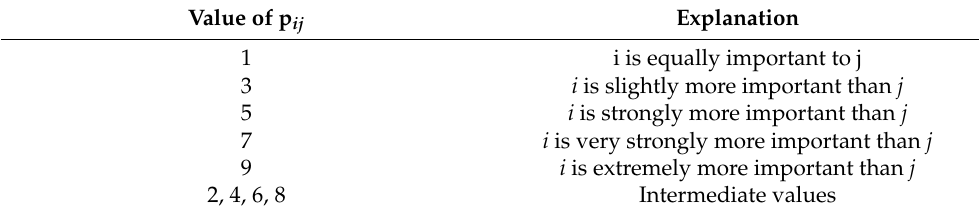
Table 3. AHP scale for pairwise